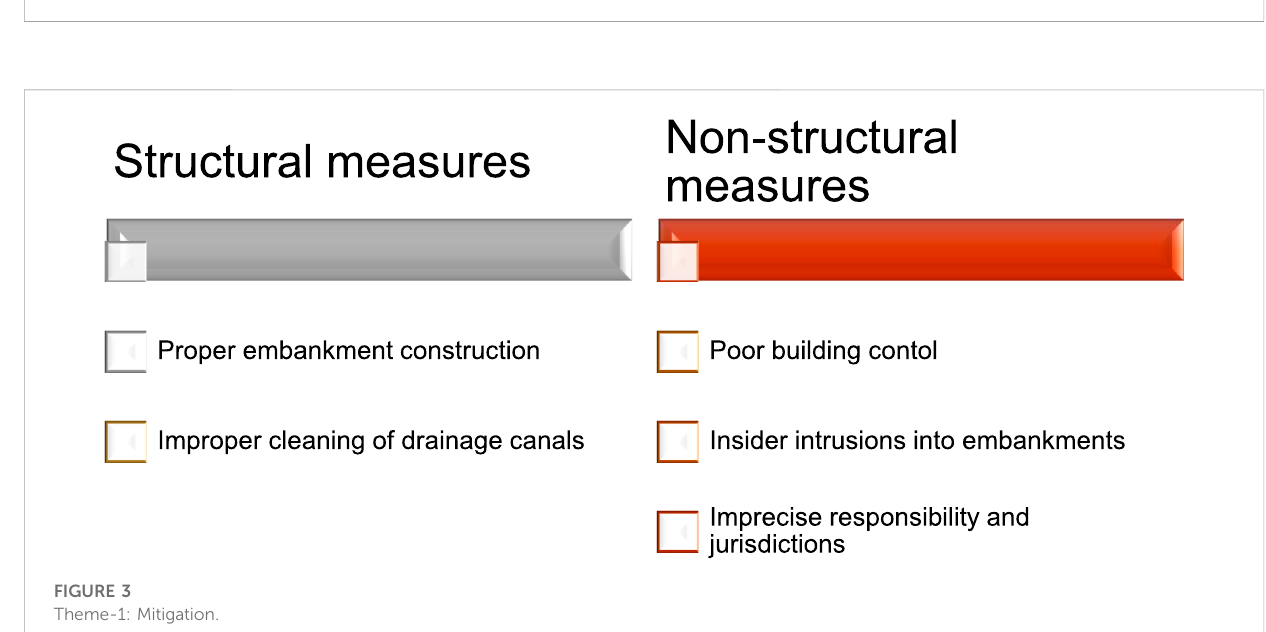
FIGURE 2 Summary of the themes and sub-themes used to unveil challenges in rural fl ood risk management.